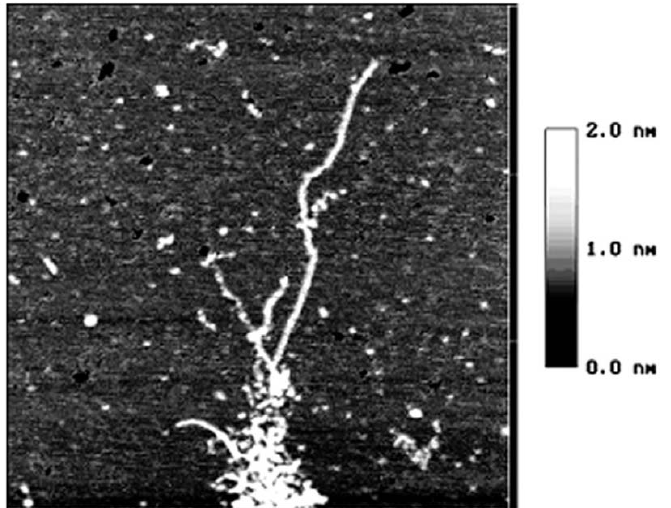
Figure 2 . The AFM image of starch nanochains when heated in 90 °C water bath for 5 min size 1.5 × 1.5 µm [13]